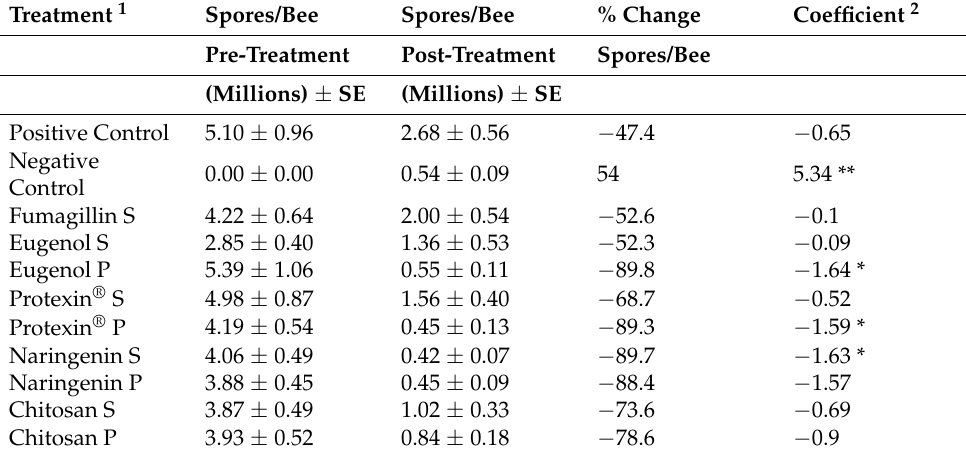
Table 1. Effect of spring 2017 treatments on Nosema ceranae spore numbers per bee one-two days pre-treatment and three weeks post-treatment with the antibiotic fumagillin, prebiotics eugenol, naringenin or chitosan, or probiotic Protexin ® . Coefficients indicate how the log of spores per bee changed relative to the positive control. Means are from 100 bees in six colonies for each treatment.